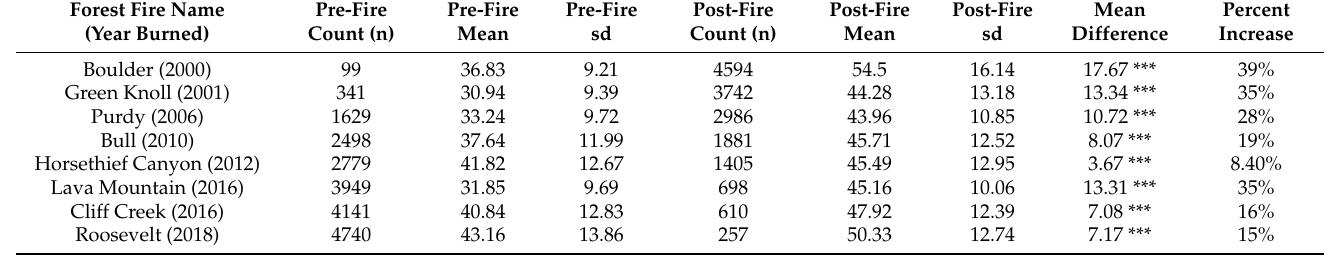
spring (Figure 4; winter mean = 54.4, sd = 9.0; spring mean = 44.0, sd = 7.5). The difference between winter and spring post-fire LSA increased with burn severity, demonstrating the dependence of LSA on forest density. Post-fire winter LSA persistently increased by 1.3 per year following a fire, while spring LSA measurements increased by 1.0 per year fol- lowing a fire event, suggesting a potential influence of post-fire radiative forcing on sur- face snow albedo during the springtime snowmelt phase.